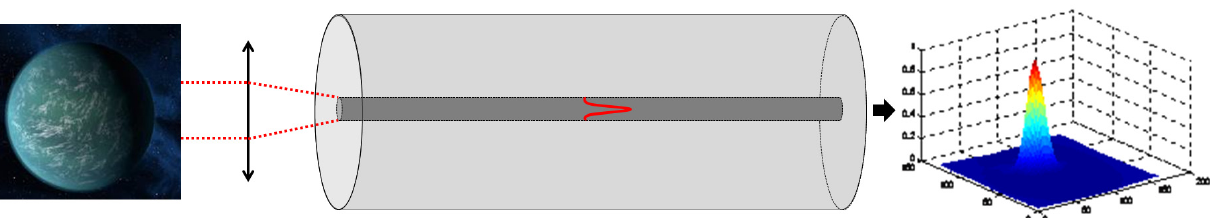
Figure 8. Optical configuration of a single mode, core/clad fiber required for space exploration by filtering the signal in the